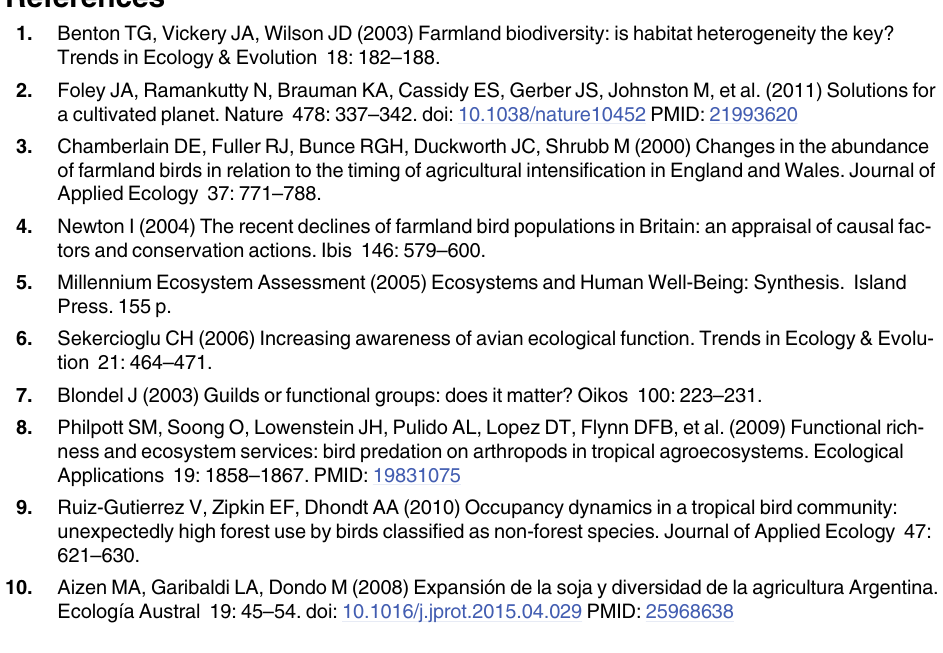
S1 Table. Avian species observed in the regional monitoring program in Pampas and Esp- inal regions, in Argentina from 2003 – 2012 (registered > 200 times). Groups for analyses purposes and guilds are indicated: raptors (RAP), ground omnivores and herbivores (OMN), ground granivores (GRA2), other granivores (GRA), insectivores mostly associated with folli- age (INS1) and other insectivores (INS2) [43,48,49]. S2 Table. Posterior proportion of forest effects on detection probabilities in the logit scale ^ b (logit( forest )), with upper and lower 95% BCI (LBCI, UBCI) for each species in the regional bird monitoring program in Argentina, 2003 –